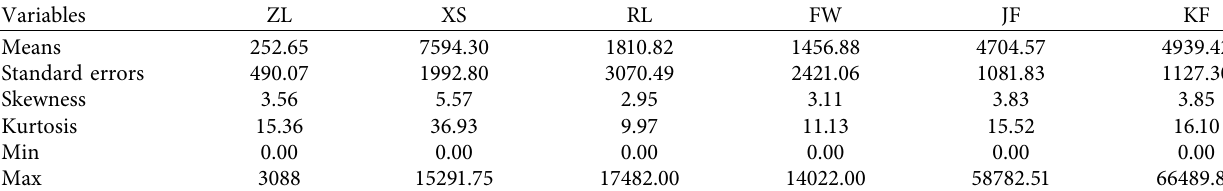
Table 3: Te description of